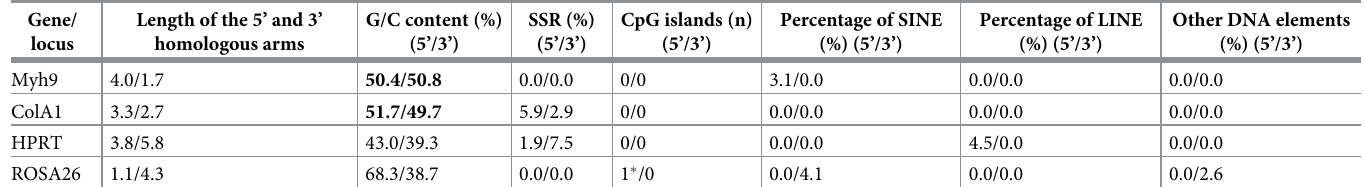
GC content represents the percentage of nucleotides in the strand that possesses either cytosine or guanine bases; Simple sequence repeat (SSR) consists of short, tandemly repeated di, tri-, tetra- or penta-nucleotide motifs; CpG island is a short stretch of DNA in which the frequency of the CG sequences is higher than other regions; SINEs denotes short interspersed nuclear elements; LINEs denotes long interspersed nuclear elements; � CpG island located at the position of